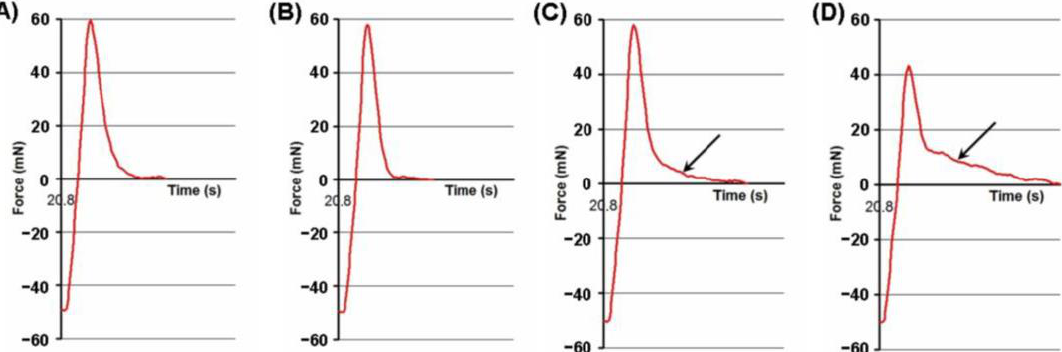
Figure 11. Tensile strength adhesive curve (red line) of non-treated FeP ( A ) and FeP pre-incubated in Hanks’ solution with a pH of 5.0 ( B ), 7.4 ( C ), and 8.0 ( D ) for 24 h. The black arrow indicates the protraction of the debonding curve.